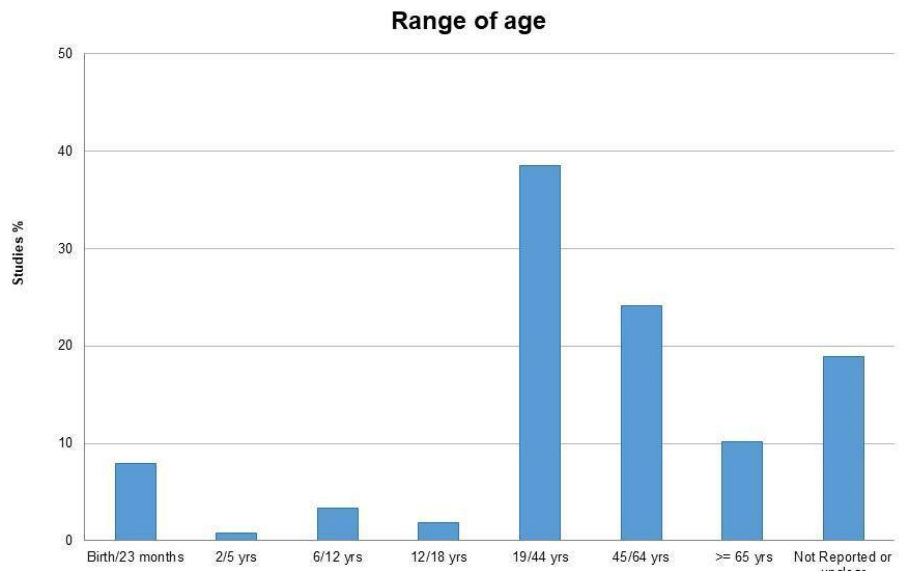
Figure 2. Classification by age categories of individuals enrolled in the studies included in this review, reported as percentages with respect to the sample totality.